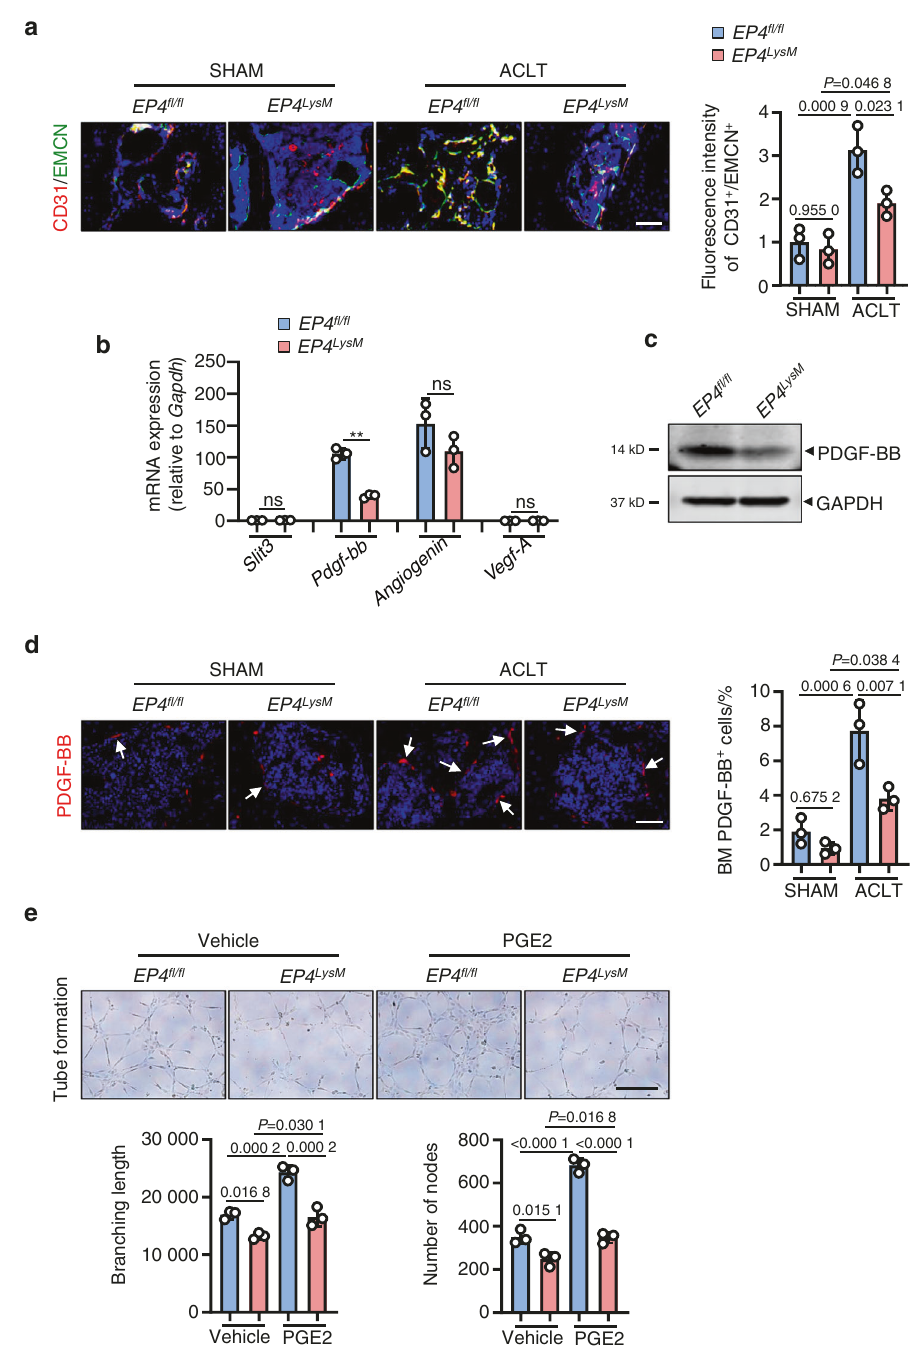
Fig. 4 EP4 deletion in osteoclasts reduces type H blood vessels in subchondral bone via inhibition of PDGF-BB secretion. a Representative images for IHF staining of EMCN (green) and CD31 (red) in subchondral bone of the EP4 fl / fl or littermate EP4 LysM mice 2 weeks after ACLT surgery (left) and corresponding quantitative analysis (right). Error bars are the mean ± s.d. Two-way ANOVA followed by Tukey ’ s t tests. n = 3 for each group. Scale bars, 20 μ m. b qRT-PCR analysis of the mRNA levels of Slit3 , Pdgf-bb , Angiogenin , and Vegf-A in osteoclasts generated from BMMs of the EP4 fl / fl or littermate EP4 LysM mice stimulated with 10 ng·mL − 1 M-CSF and 50 ng·mL − 1 RANKL and incubated with 100 nmol·L − 1 PGE2 for 24 h. Error bars are the mean ± s.d. n = 3. ** P < 0.01 and ns, not signi fi cant by one-way ANOVA followed by Tukey ’ s t tests. c Representative images of PDGF-BB protein expression by western blotting of osteoclasts generated using BMMs from the EP4 fl / fl or littermate EP4 LysM mice stimulated with 10 ng·mL − 1 M-CSF and 50 ng·mL − 1 RANKL and incubated with 100 nmol·L − 1 PGE2 for 3 days. The experiments were performed with three biological replicates. d Representative images of IHF staining of PDGF-BB (red) in the subchondral bone of the EP4 fl / fl or littermate EP4 LysM mice 2 weeks after ACLT surgery (left) and corresponding quantitative analysis (right). The white arrows indicate PDGF-BB IHF signals. Error bars are the mean ± s.d. Two-way ANOVA followed by Tukey ’ s t tests. n = 3 for each group. Scale bars, 20 μ m. e Representative images of the HUVEC tube formation assay (left). BMMs isolated from the EP4 fl / fl or littermate EP4 LysM mice were stimulated with 10 ng·mL − 1 M-CFS, 60 ng·mL − 1 RANKL and 100 nmol·L − 1 PGE2 for 3 days. Subsequently, conditioned medium from osteoclasts was used to treat HUVECs for 4 h. The branching length and node numbers of the HUVEC tubes were quantitated (right). Error bars are the mean ± s.d. n = 3. Two-way ANOVA followed by Tukey ’ s t tests. Scale bars, 50 μ